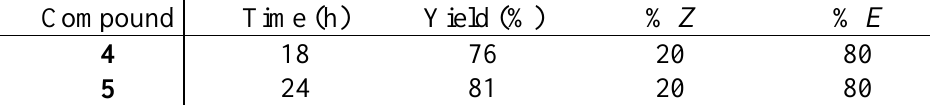
Table 2: Chemical shifts and coupling constants of H